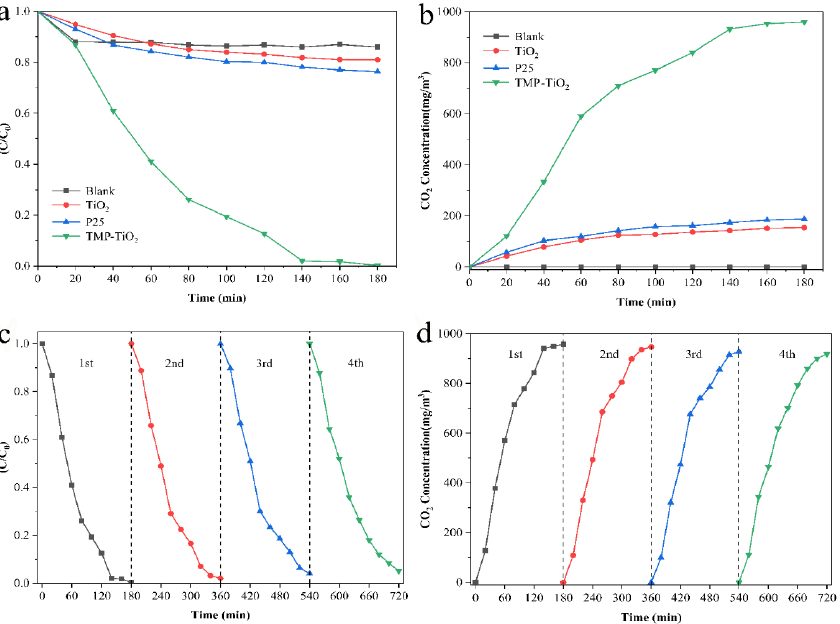
Figure 10. ( a ) Degradation rate of benzene gas concentration with visible light irradiation, ( b )